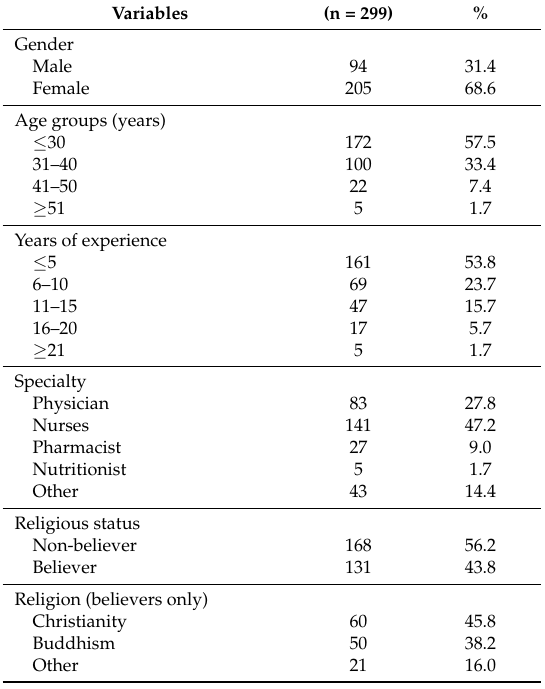
Table 1. Characteristics of health professionals who responded to the survey.